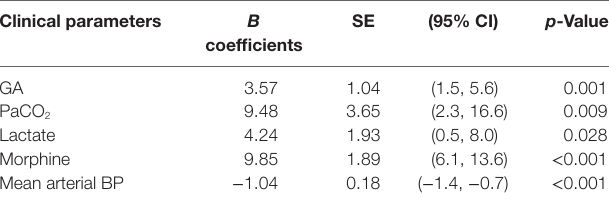
TaBle 2 | Mixed effects multiple regression analysis between mean EEG discontinuity and clinical parameters. clinical